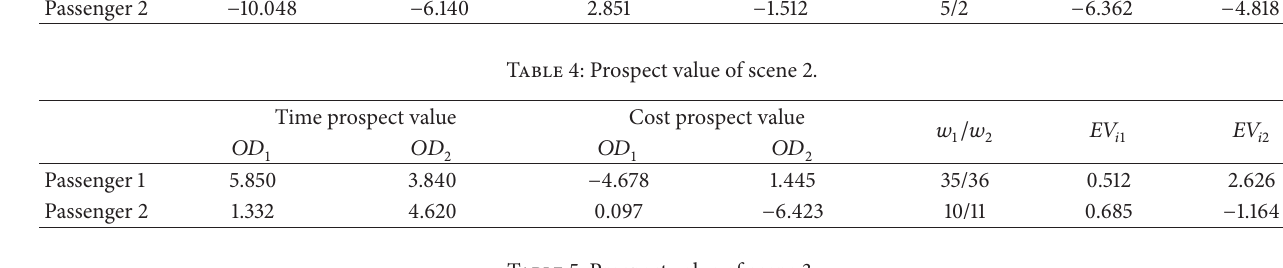
Table 5: Prospect value of scene 3.